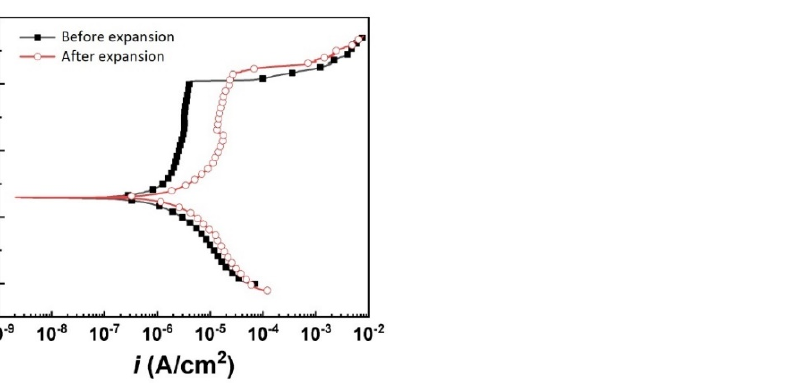
Figure 5. Polarization curves of AISI 304 SS before and after expansion in the test solution.